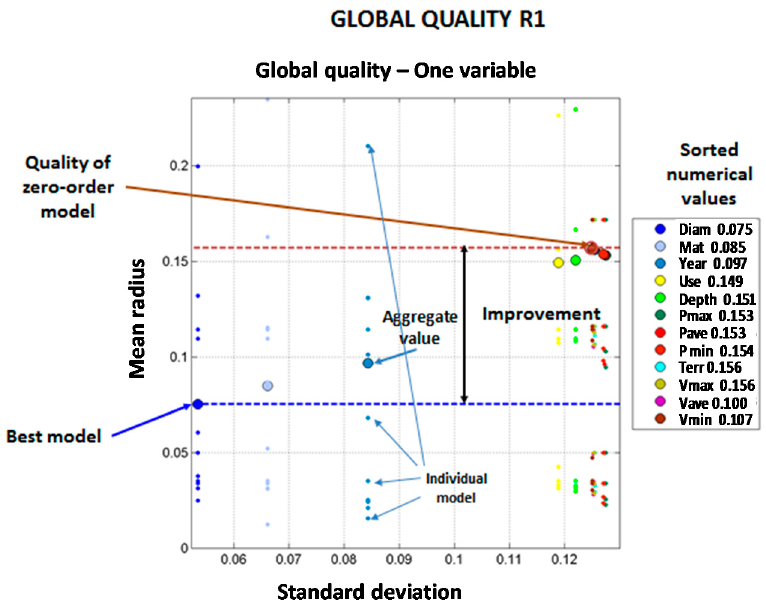
Figure 2. Global quality figure explanation. Mean radius is represented versus standard deviation for each validation point of each model. Average mean radius is represented by a larger dot of the same color. The legend presents the average values of mean radius obtained for each variable. Order zero mean radius is represented with a brown dashed line; the best model is represented with a blue dashed line. Improvement from order zero to best model is indicated as the distance between both lines.